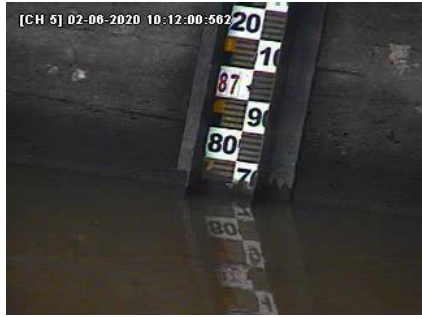
Figure 2. Original image from recorded